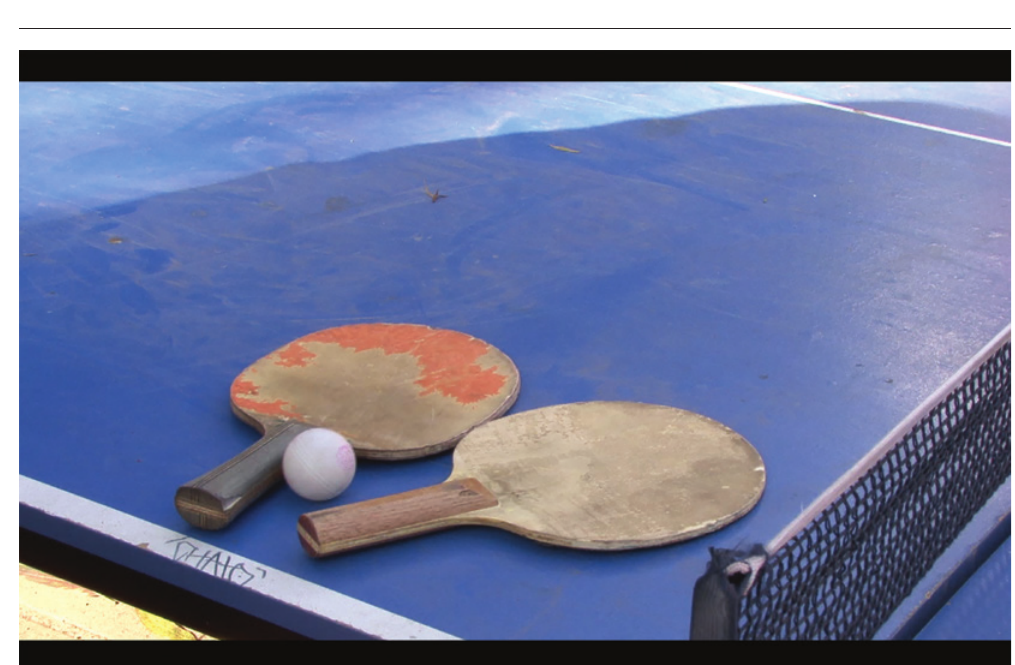
Figure 4: Still frame of an experimental shot taken shortly after introduction of the filming